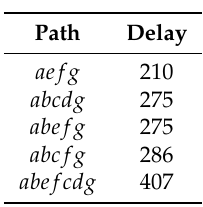
Table 6. Worst case end-to-end